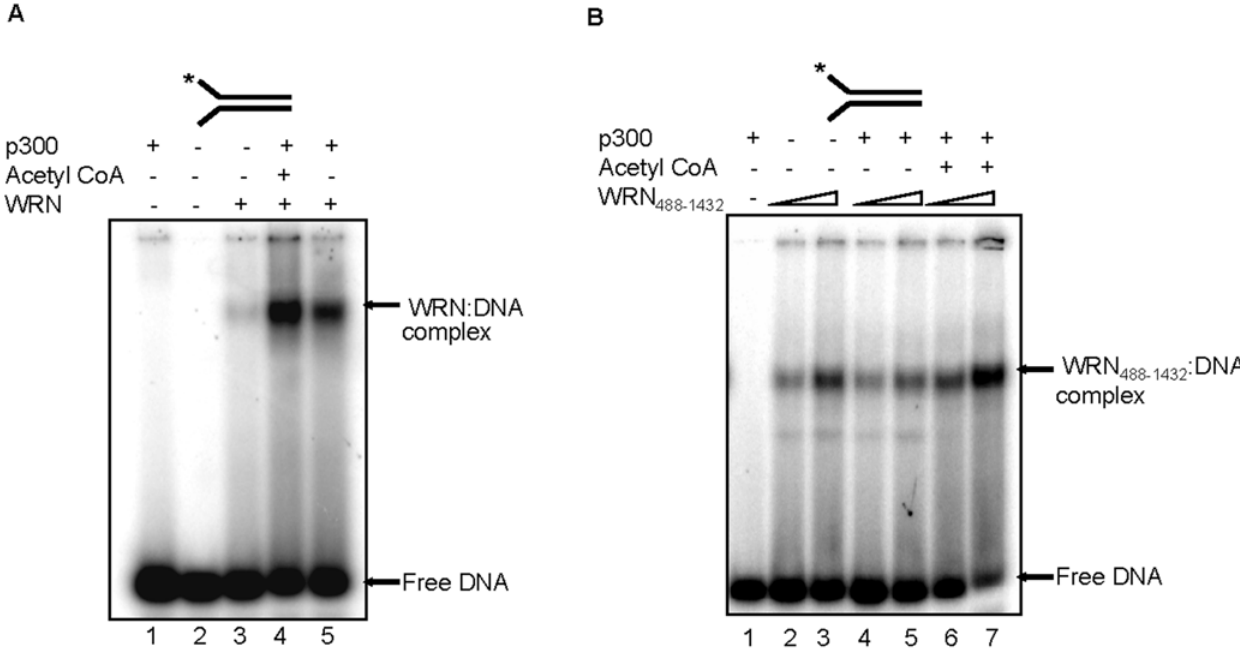
Figure 7. Acetylation of WRN and WRN 488–1432 stimulates their DNA binding activities. Reactions were run under the conditions described in Materials and Methods on a 5% acrylamide gel and visualized using a PhosphorImager. (A) Acetylated WRN and WRN-p300 complex have higher DNA binding affinity. ( B) Acetylated WRN 488–1432 has higher DNA binding activity.